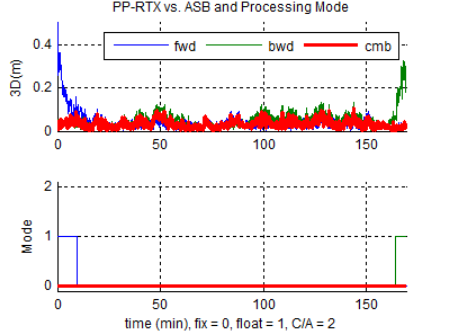
Figure 11: Forward, Backward & Combined PP-RTX vs. ASB™ and Processing Mode (Typical